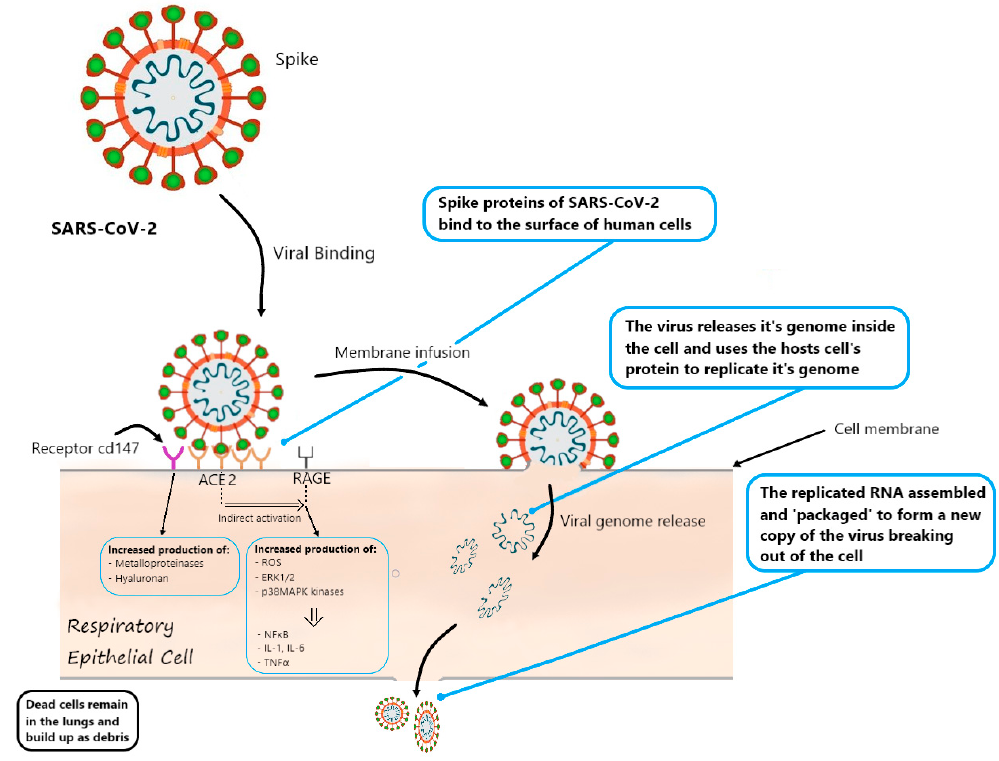
Figure 1. Diagram of infection and its consequences in the epithelial cell of the respiratory system.